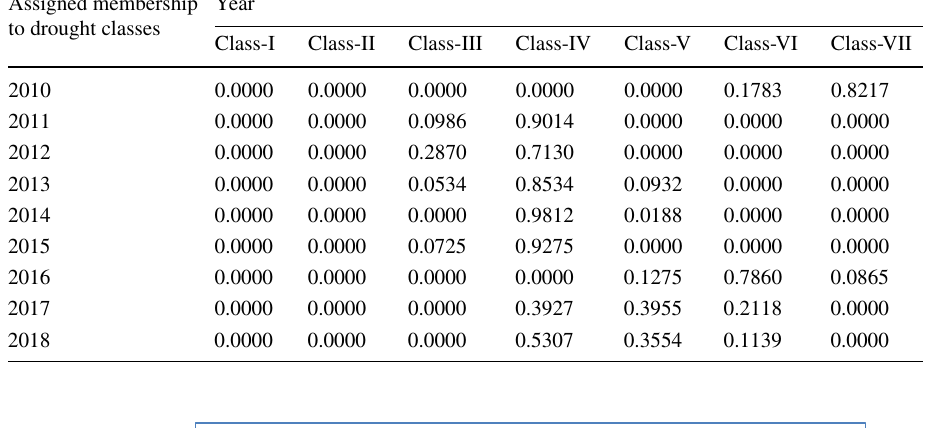
each drought class according to the Fuzzy -kNN model